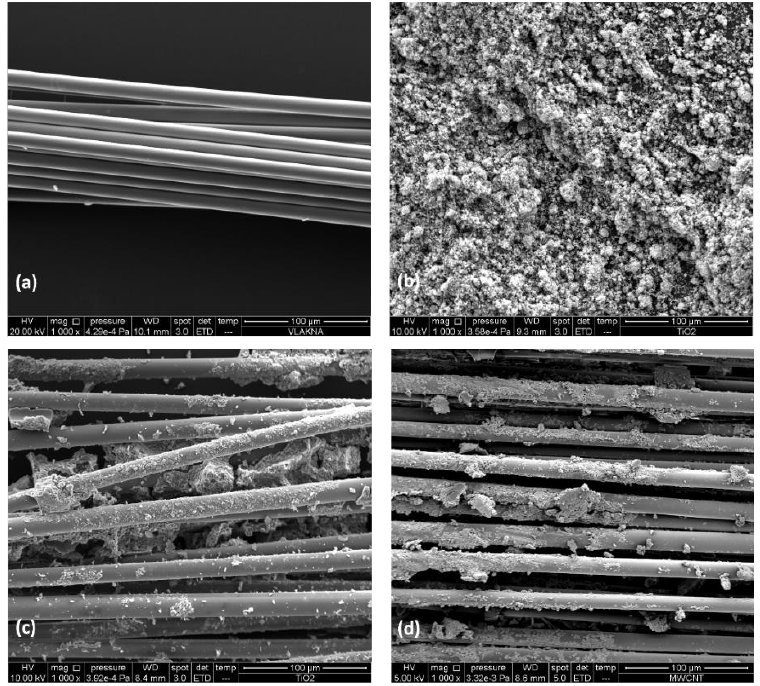
Figure 1. The SEM images: ( a ) clean GF mesh, ( b ) TiO 2 , ( c ) TiO 2 -GF mesh, and ( d ) TiO 2 /CNT-GF mesh.